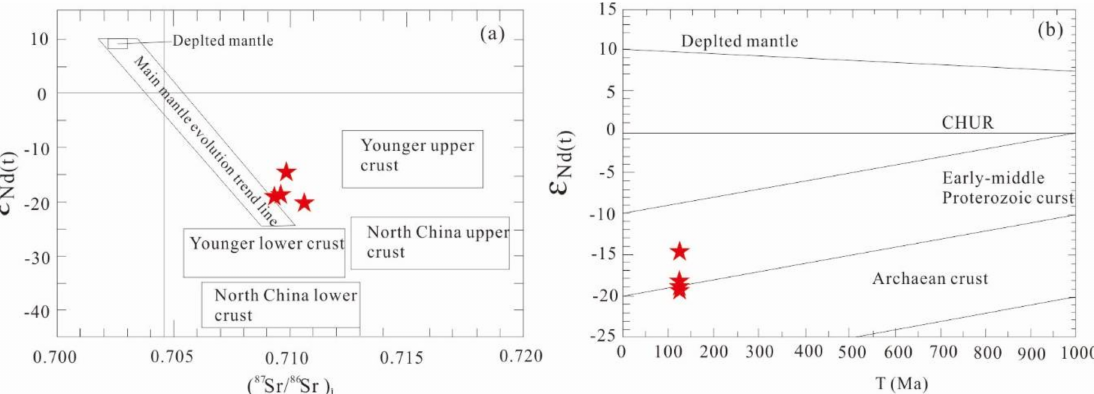
Figure 10. ( 87 Sr/ 86 Sr) i vs. ε Nd (t) isotope diagramand ε Nd (t) vs. T diagram of the Zhouguan granodi- orite (( a ) after Zhou et al., 2012 [87]; ( b ) after Jahn, 2000